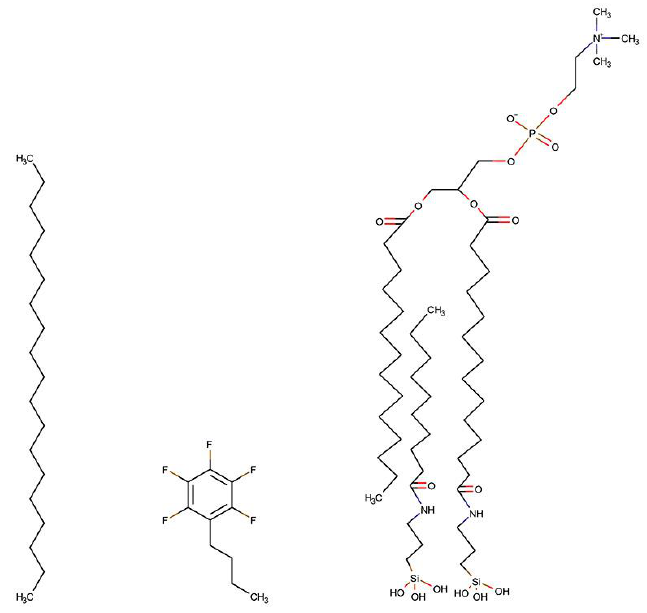
Figure 5. Structures of the ligands chemically-bonded to the three stationary phases. Table 5. Physicochemical parameters of the evaluated chromatographic columns.